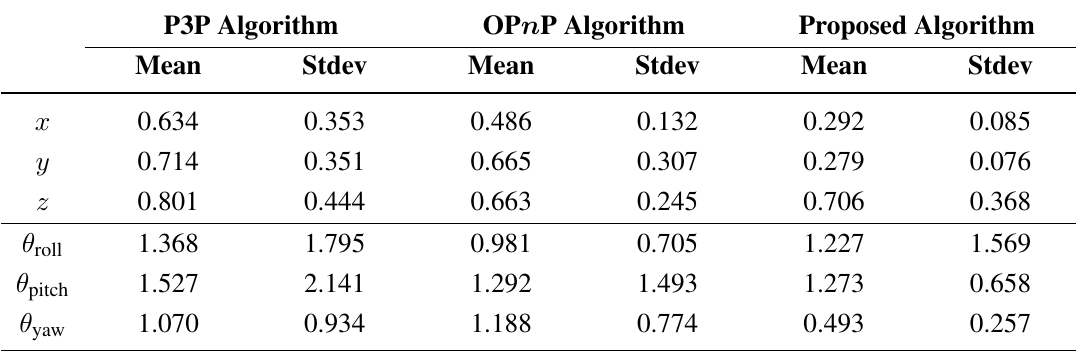
Table 1. Comparison of the error statistics of the conventional and the proposed algorithms in the simulation environment (Unit: m,